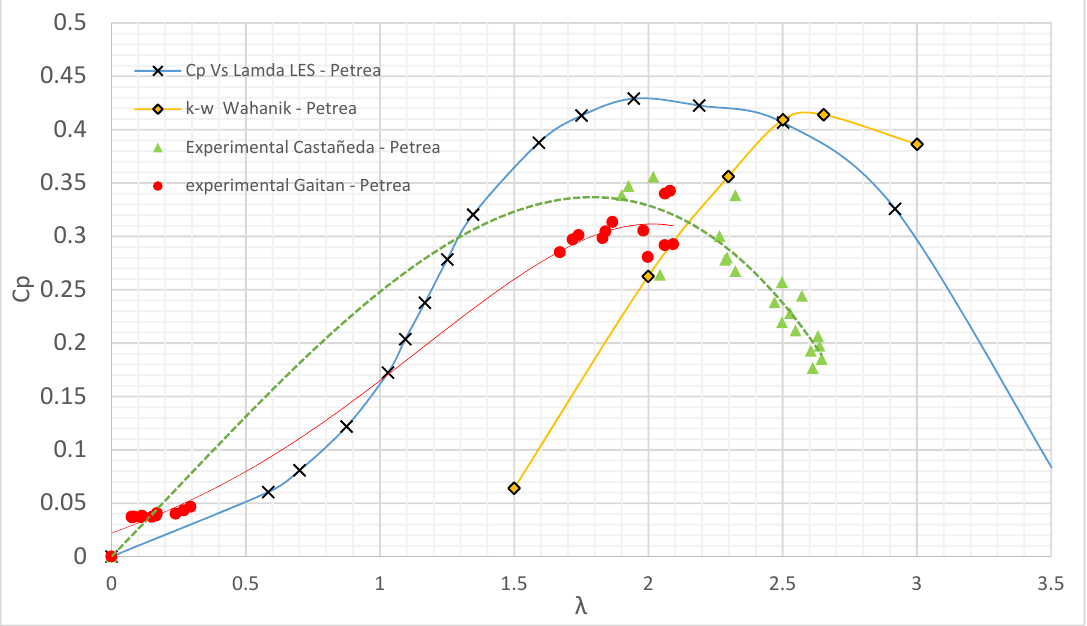
= 15 ◦ . Machigua (Petrea) seed Figure 17. Cp Vs TSR. Pitch angle = 15°. Machigua (Petrea) seed Rotor. Figure 17. Cp Vs TSR. Pitch angle = 15°. Machigua (Petrea) seed Rotor. Figure 17. Cp vs TSR. Pitch angle